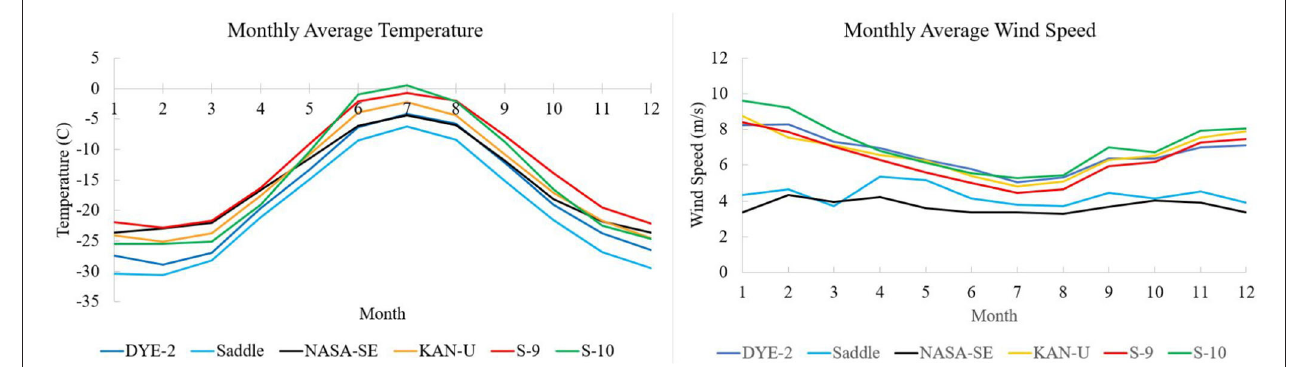
FIGURE 2 | Mean monthly temperature and wind speed for each site revealing that the southeast stations (NASA_SE and Saddle) have lower wind speeds compared to the southwest stations (S-9, S-10, KAN_U, DYE-2.) [Asa: ADD: Averaging periods differ between the stations because all available data in the time period X to Y].